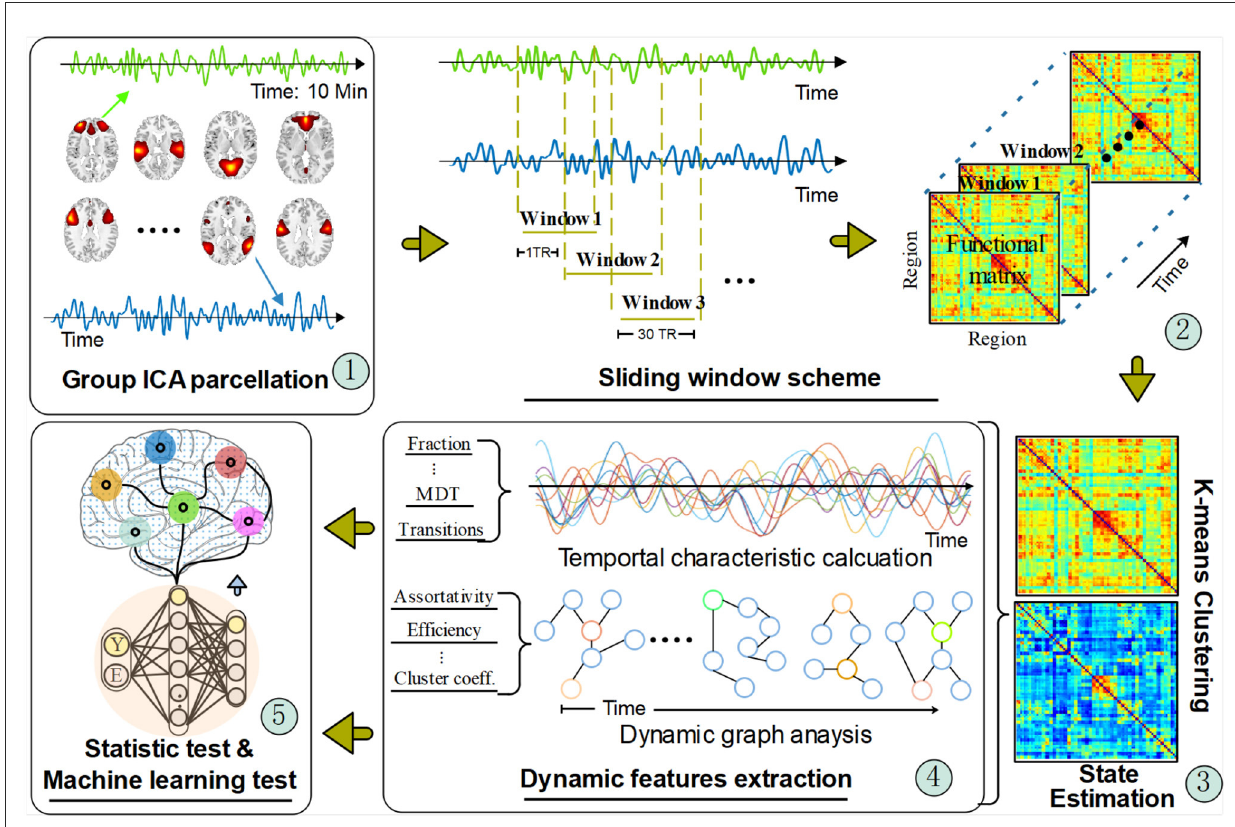
FIGURE1 The dynamic functional connectivity analysis pipeline. The timeseries signal was extracted from the network regions recognized from the group ICA parcellation method. Then, the regional timeseries were decomposed with a sliding window scheme for a time-varying function network connectivity (FNC) estimation. Those FNC matrixes were fed into a clustering algorithm to obtain different transient brain states by forming a cluster centroid. After that, two types of dynamic features were calculated based on the acquired transient states and temporal signals. Finally, statistical and machine learning methods were applied to verify the extracted dynamic FC